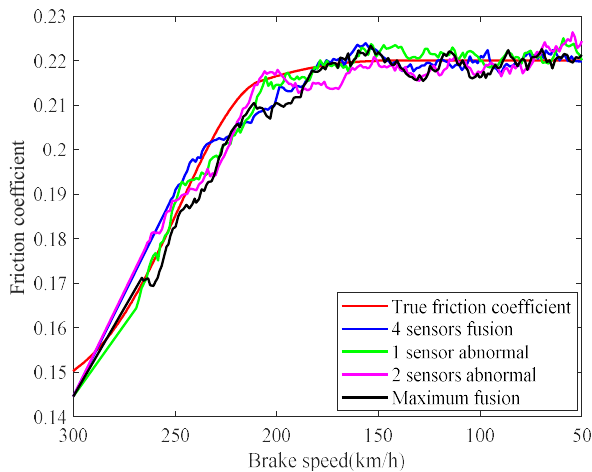
Figure 12. Identifications of friction coefficient.